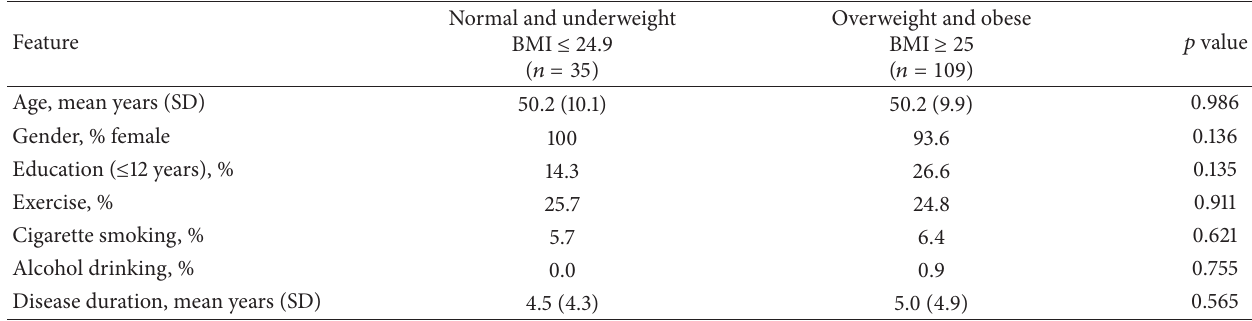
Table 1: Sociodemographic characteristics and health-related behaviors in nonoverweight/obese and overweight/obese patients with fibromyalgia syndrome.